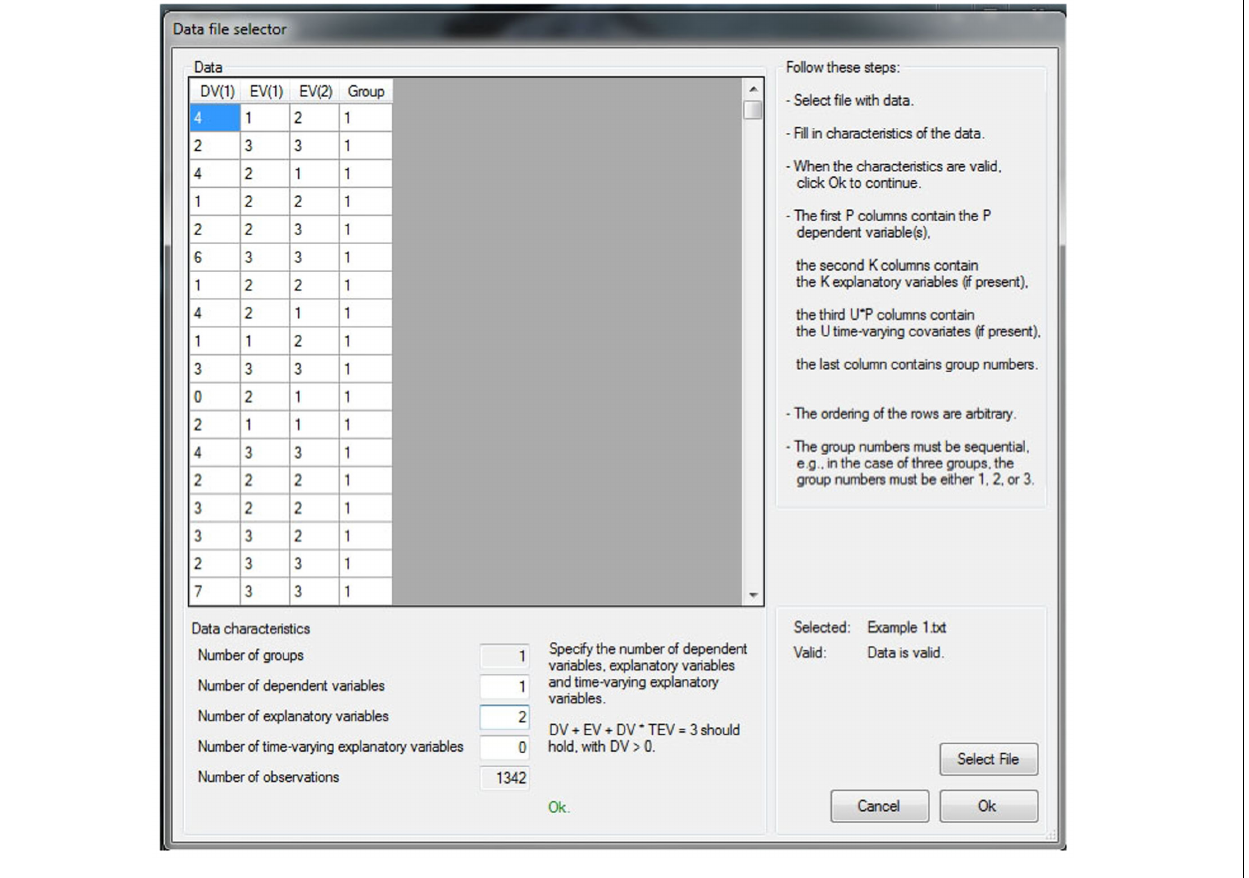
FIGURE 2 | Importing dataset into